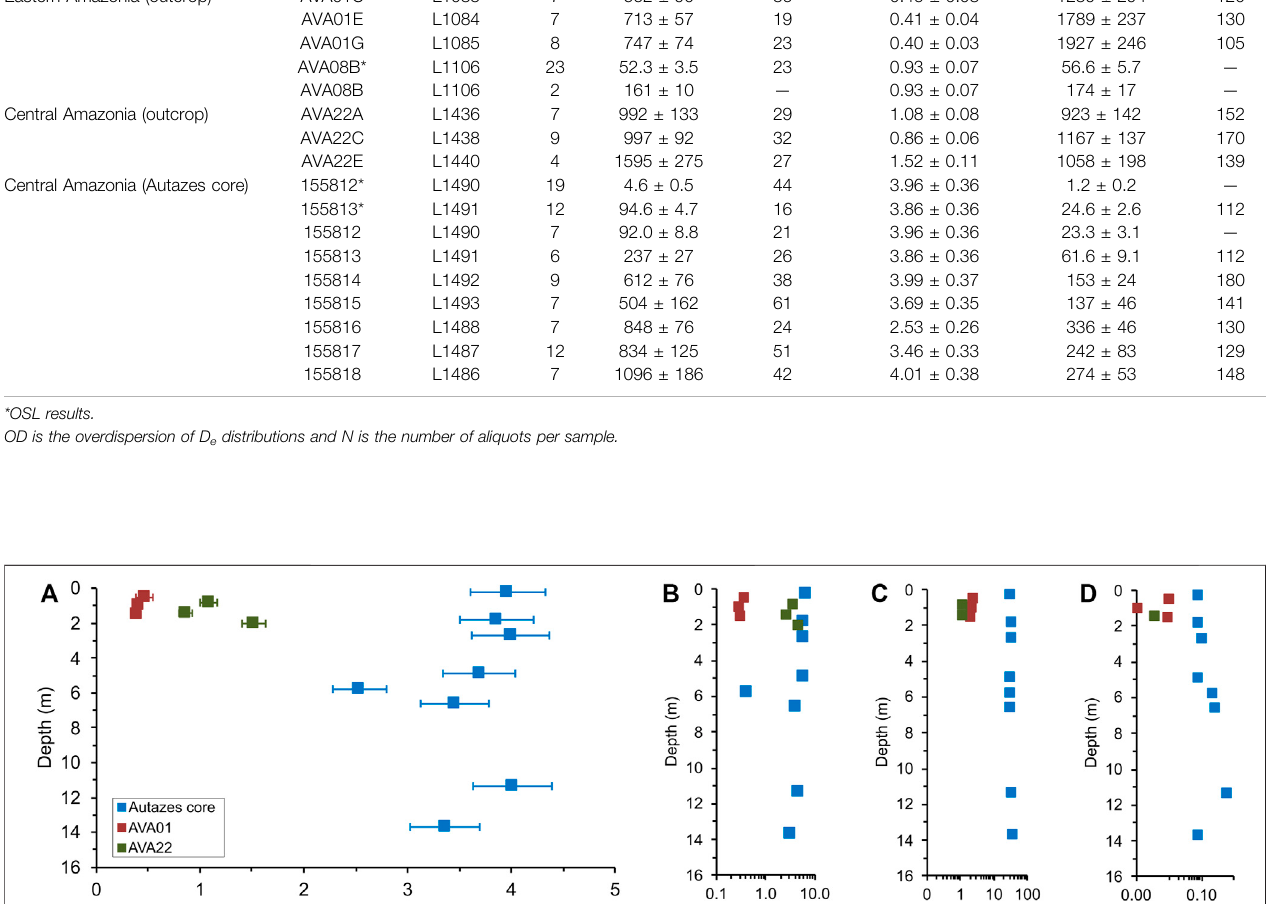
TABLE 3 | Summary of OSL and TT-OSL dating results. Location Sample Eastern Amazonia (outcrop)